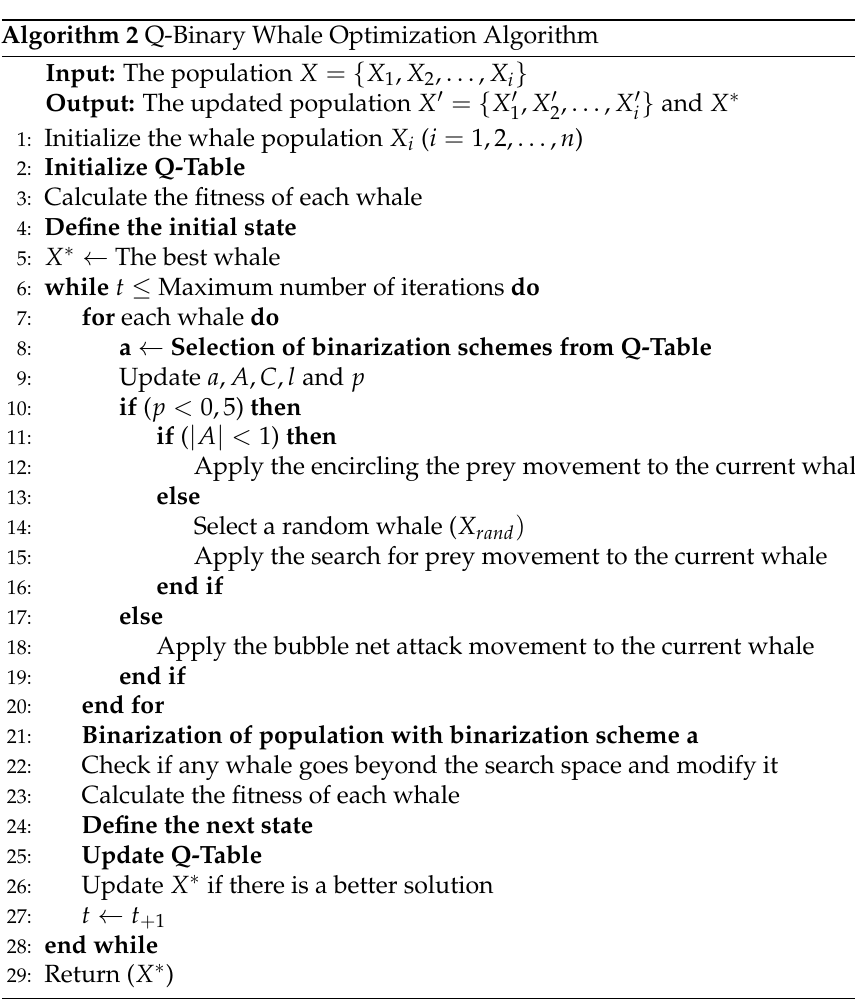
Algorithm 2 Q-Binary Whale Optimization